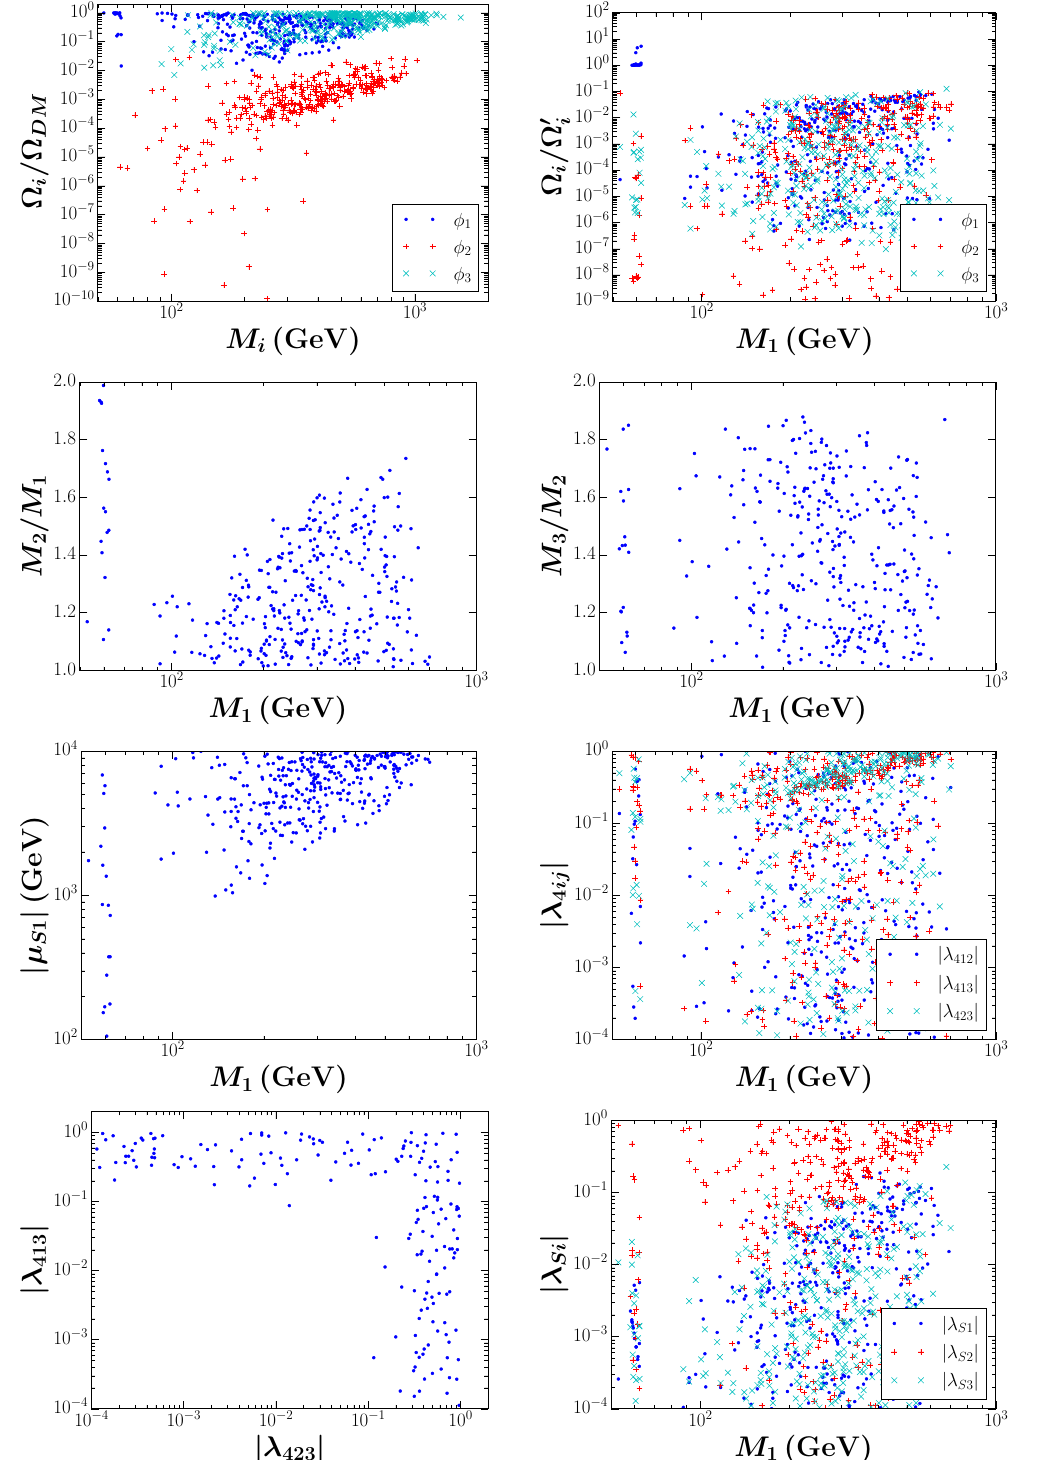
Figure 7 . The viable regions for µ S 1 6 = 0 and λ 4 ij 6 = 0 (scan C). All points shown in these plots are compatible with current